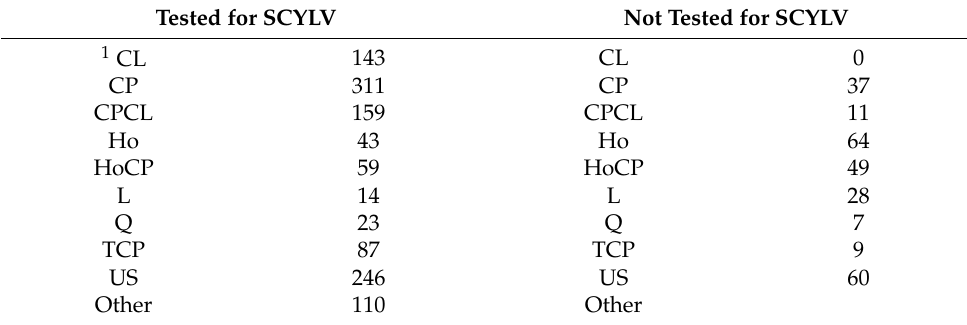
at the SH location in 2016 and the PF location the following year. In 2015, nine varieties in primary increase and five varieties in the secondary increase were surveyed. In 2016, the Table 1. Number of varieties in Canal Point breeding nursery in 2016. primary and secondary increases had eight varieties in each trial but only two varieties were on muck soil. In 2017, 2018, and 2019, the primary and secondary increase trials together, Tested for SCYLV respectively, consisted of 17, 9, and 11 varieties. Table 1. Number of varieties in Canal Point breeding nursery in 2016. Tested for SCYLV Not Tested for SCYLV